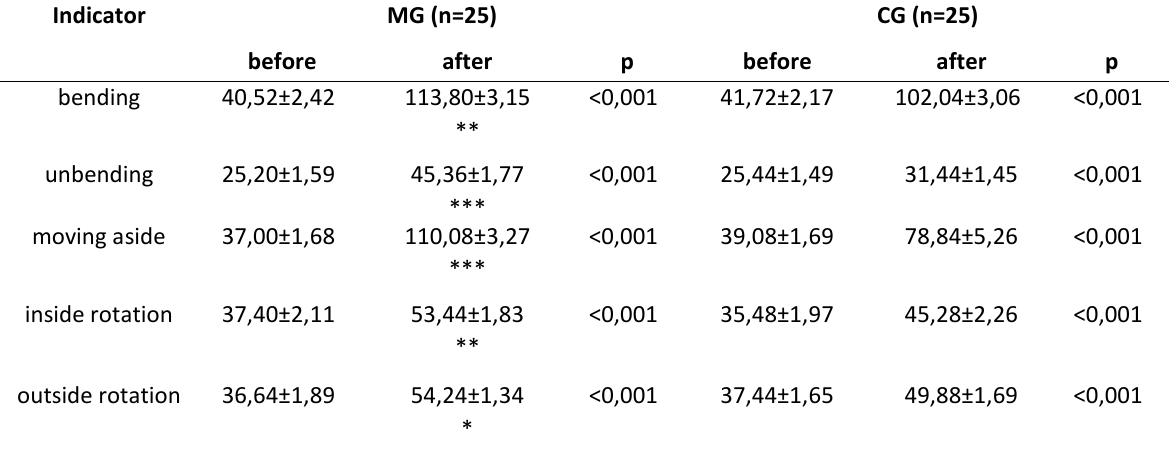
Table 1. Change of goniometry indicators on operated side (M±m) of MG women in comparison with CG at rehabilitation stationary